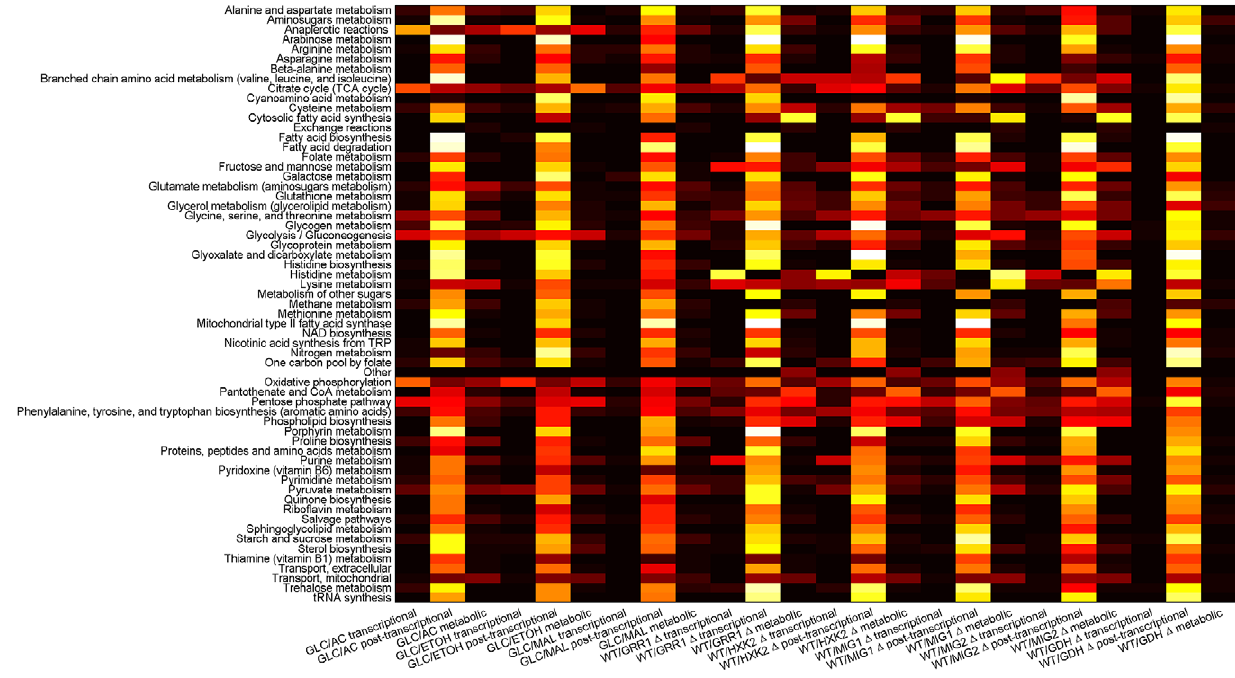
Figure 6. This figure illustrates the extent of transcriptional, post-transcriptional and metabolic regulation observed in different metabolic processes for each of the studied cases. The metabolic processes are defined in the same way as in the iFF708 model. The brightness of the color is proportional to the probability of a reaction in the corresponding process to show transcriptional, post-transcriptional and metabolic regulation respectively. The black correspond to 0 and the white to 1.